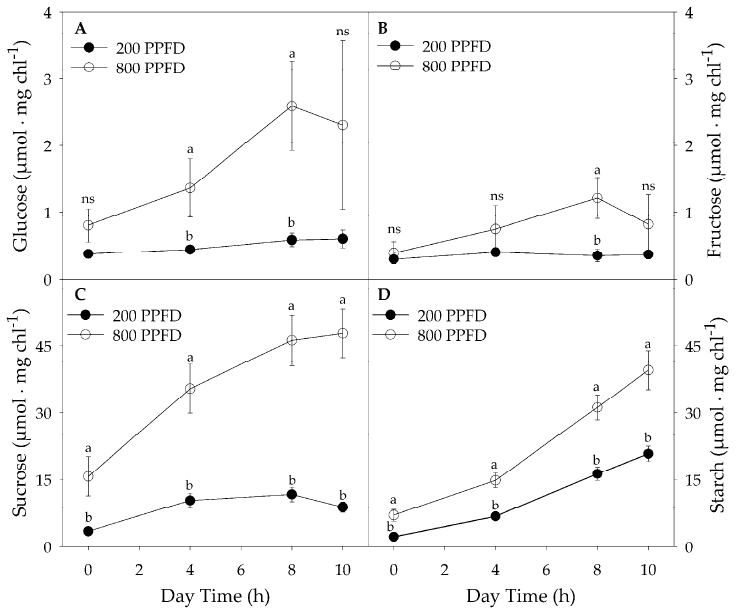
Figure 3. Accumulation of glucose ( A ), fructose ( B ), sucrose ( C ), and starch ( D ) during the light period in leaves of plants grown under 800 μ mol m − 2 s − 1 (800 PPFD) and 200 μ mol m − 2 s − 1 (200 PPFD) white light intensity. Mean values ± S.E. (n = 12). Different letters indicate significant differences at p = 0.05 (Fisher’s post-hoc test), ns—not significant.